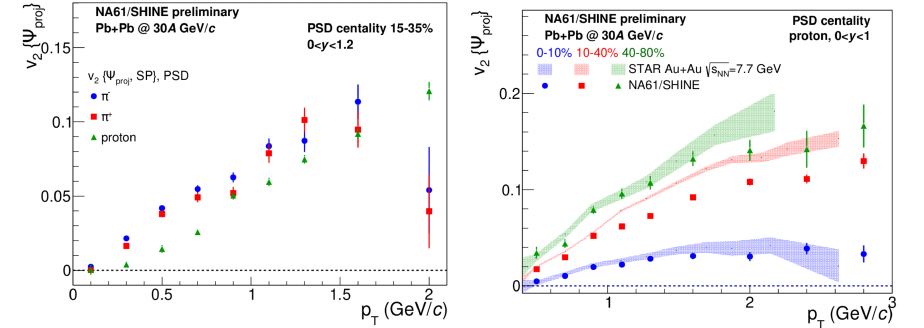
Figure 9. Left: Transverse momentum dependence of ν 2 for di ff erent particle types in Pb + Pb colli- sions at 30 A GeV / c. Right: Transverse momentum dependence of protons’s ν 2 in Pb + Pb interactions measured by NA61 / SHINE and in Au + Au interactions measured by